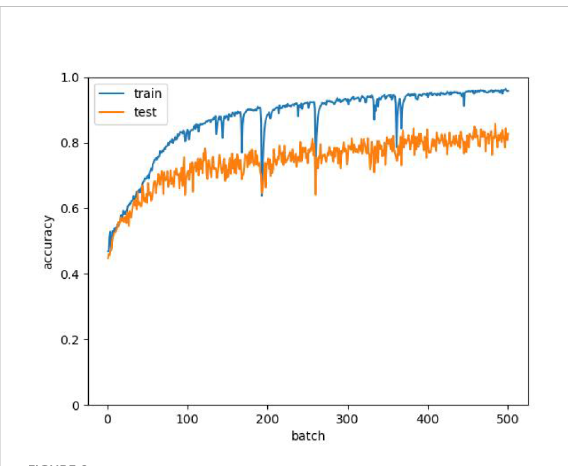
FIGURE 9 Accuracy of D-SA-FCN model training set and test